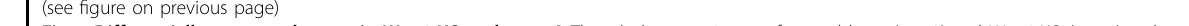
Fig. 5 Differentially expressed genes in Wwc2 KO embryos. A The whole transcriptome from wildtype ( n = 3) and Wwc2 KO ( n = 4) embryos at E11.5 was compared. Volcano plot with (base 2) logarithmic fold change (FC) plotted against the negative (base 10) logarithmic p -value. Each of the 20,653 detected genes is represented by a dot. For an in-depth analysis, a threshold was set indicated by the dashed lines. Genes exceeding that threshold are marked in green, resulting in 1984 genes with an FDR-corrected p -value < 0.05 and a log2(FC) > 1 that were taken into account. Genes below that threshold are marked in gray and were ignored for further analysis. Genes related to the Hippo signaling are marked in red (KEGG pathway: Hippo signaling pathway). B Graph showing the group of 1984 signi fi cantly deregulated genes with FDR-corrected p -value < 0.05 and log2 (FC) > 1 divided in upregulated genes ( “ Up ” , 1362 genes, blue) and downregulated genes ( “ Down ” , 622 genes, red). C qRT-PCR analyses with RNA isolated from control ( n = 3) and Wwc2 KO embryos ( n = 3) at E11.5. The known YAP target genes Krt19, Cyr61 , and Ctgf are signi fi cantly upregulated in Wwc2 -de fi cient embryos. D Expression of the angiogenesis-related genes Pecam1, Vegfa, Flt1 , and JunB is upregulated in Wwc2 KO